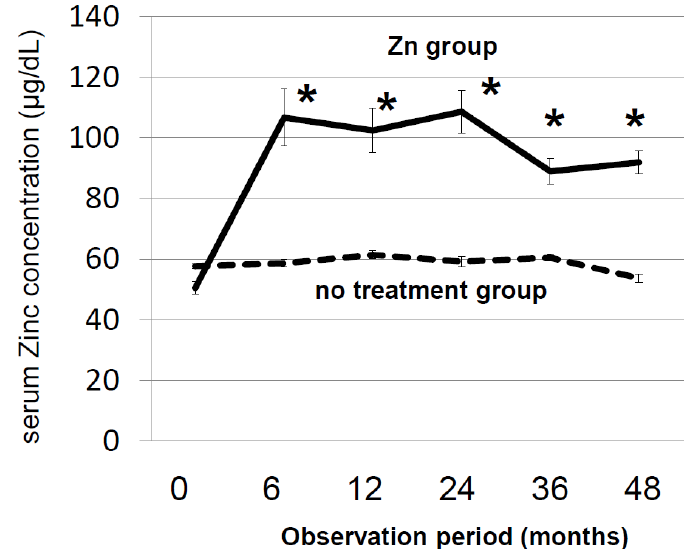
Figure 2. Serial changes in the serum zinc concentration in the Zn- and no Zn-treatment groups. Asterisks indicate significant differences (*, p < 0.001 compared to the value recorded before treatment). The zinc concentration increased to greater than 90 µg/dL in the Zn-group, and was maintained at that level for 4 years.